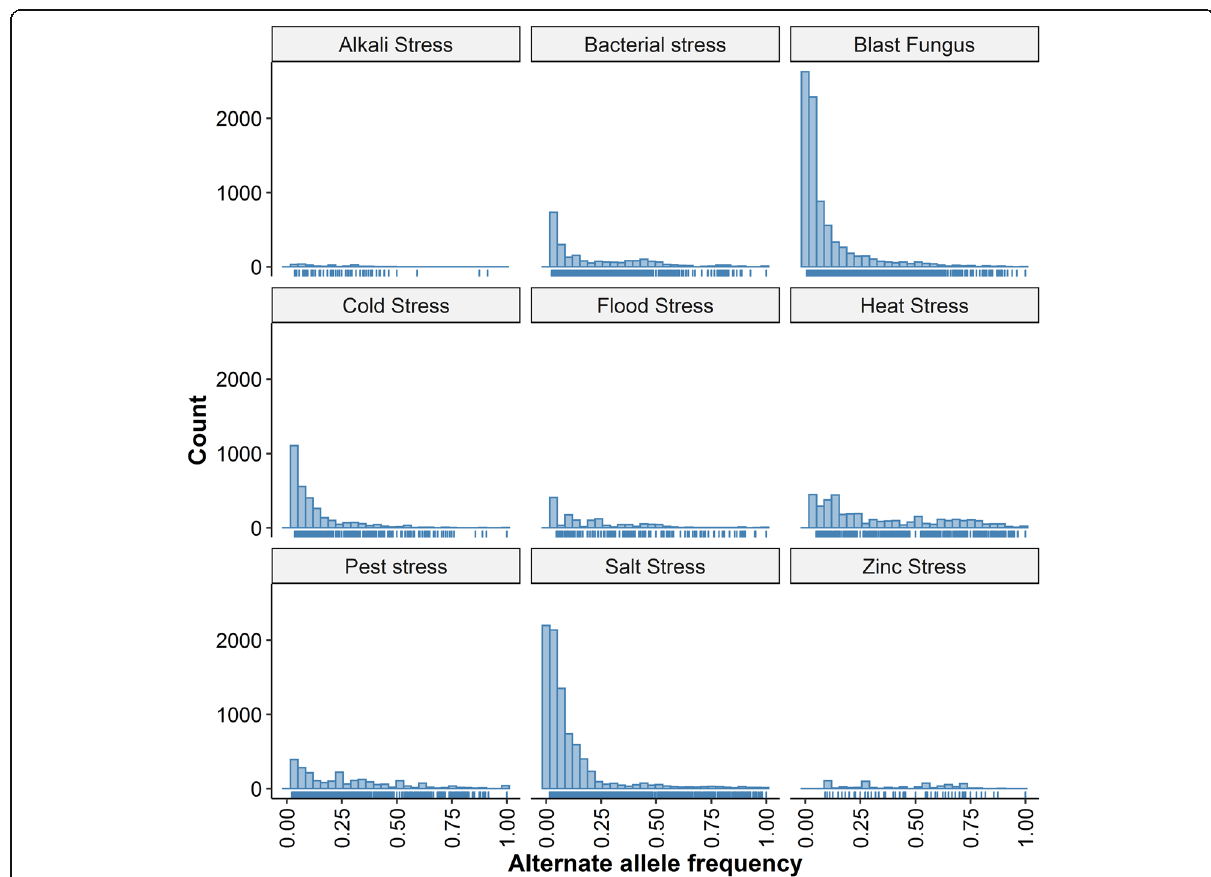
Fig. 4 The variants distribution by annotation in different abiotic and biotic stress-resistant genes in rice. The X-axis represents the variant annotation of the SNPs in these genes and the Y-axis represents the count of each annotation in these